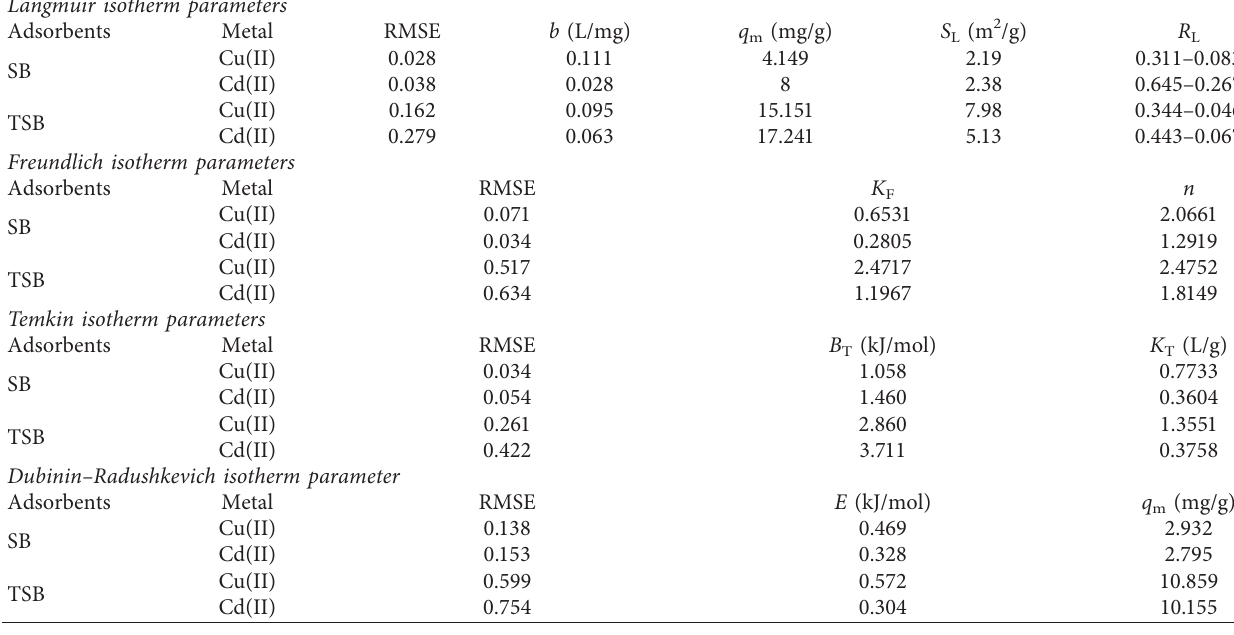
Table 3: Equilibrium parameters for Cu(II) and Cd(II) biosorption.